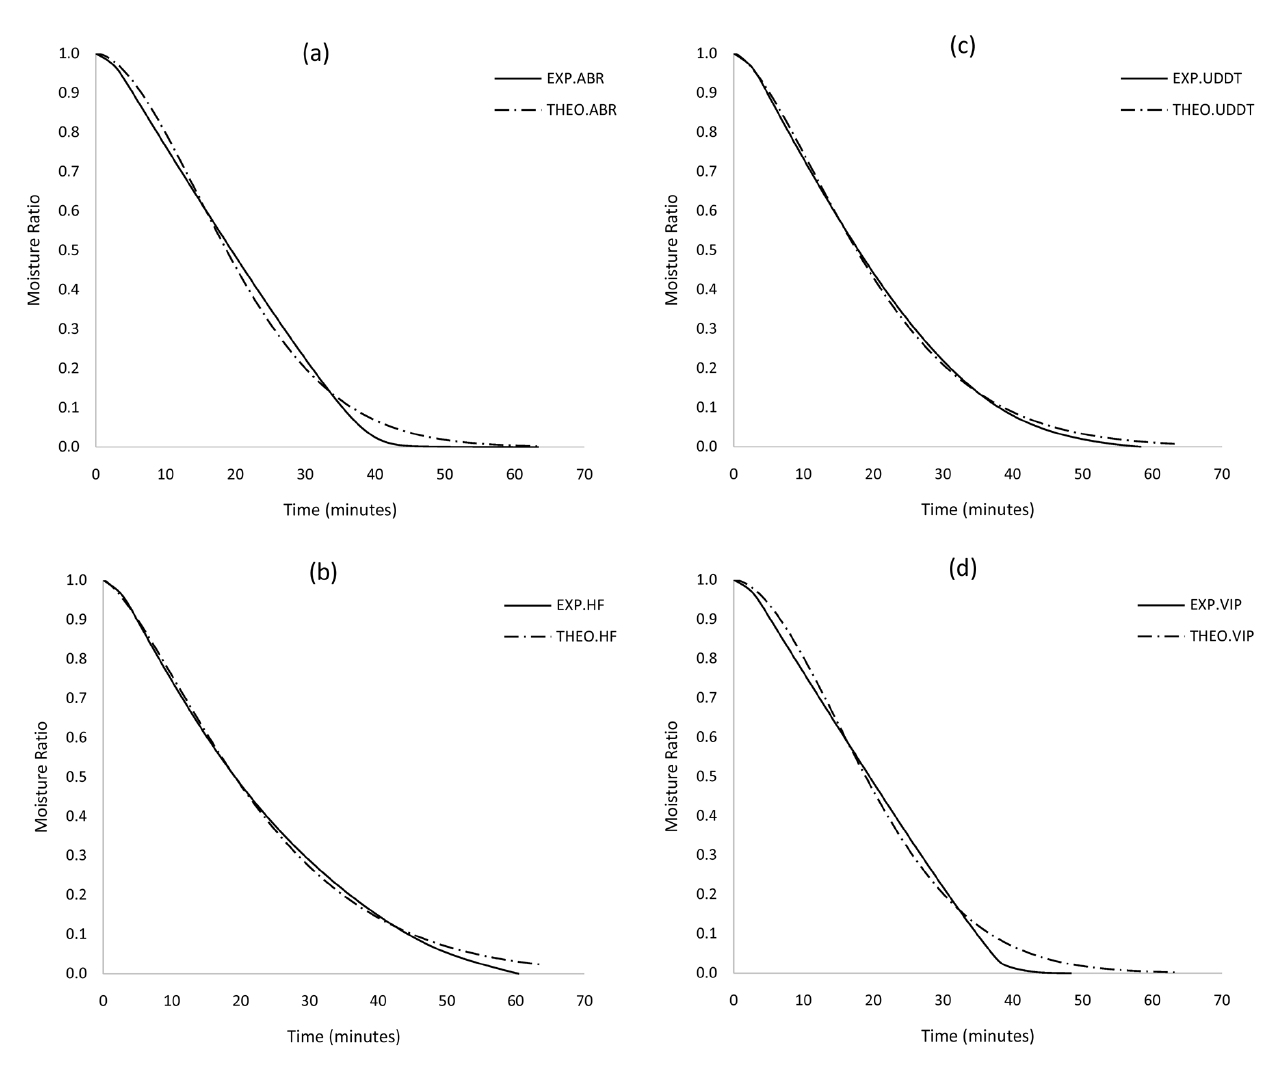
Figure 6. Predicted MR (using Page model) in comparison to experimentally determined values for different faecal sludges at 55oC: a ) ABR, b ) HF, c ) UDDT and d ) VIP. ABR, anaerobic baffled reactor; HF, human faeces; UDDT, urine-diverting dry toilet; VIP, ventilated improved pit.